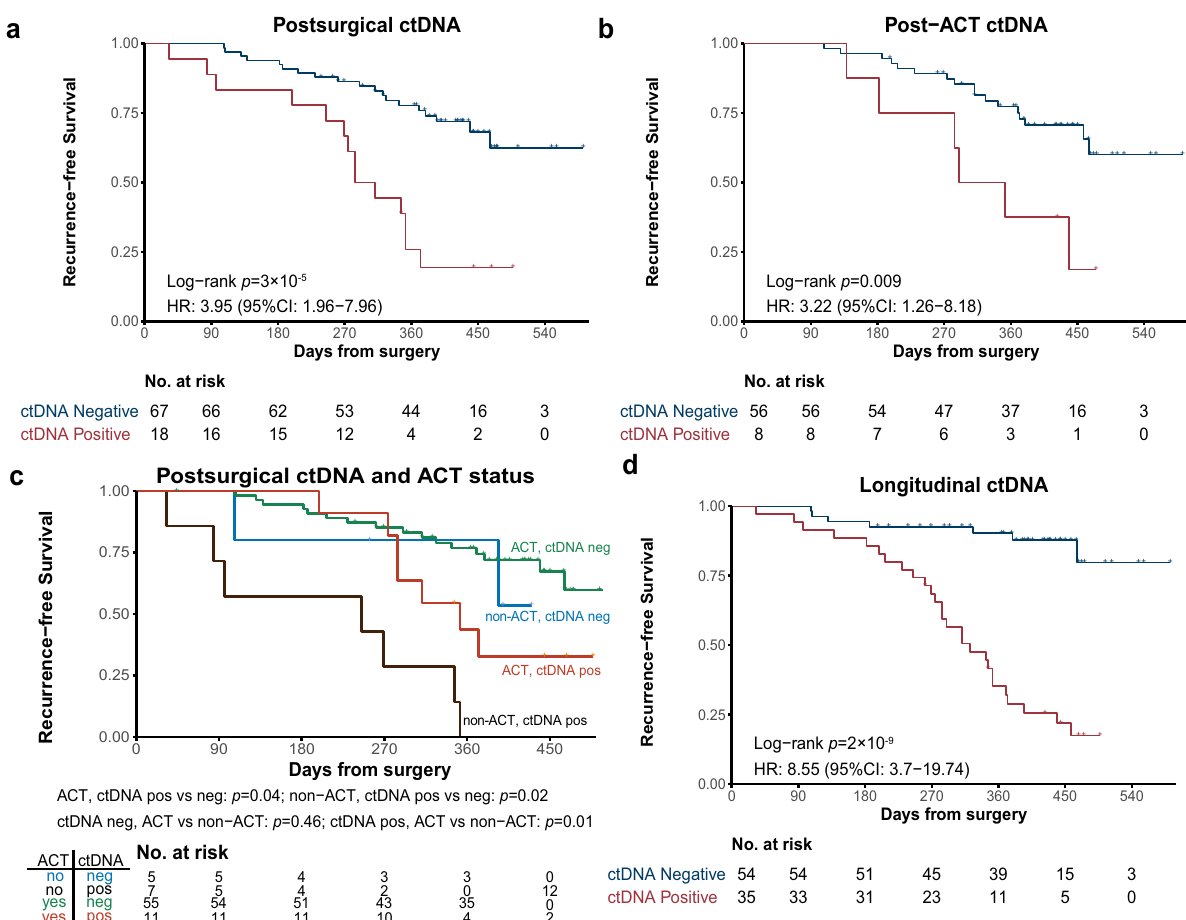
Fig. 2 ctDNA positivity could potentially serve as a prognostic marker and guide ACT treatment. a Kaplan – Meier curve of recurrence-free survival (RFS) in patients strati fi ed by postsurgical ctDNA status. p -value was calculated by the log-rank test. b Kaplan – Meier curve of RFS in patients strati fi ed by post- ACT ctDNA status. p -value was calculated by the log-rank test. c Kaplan – Meier curve of RFS in stage II – III patients strati fi ed by both ACT treatment and postsurgical ctDNA status. p -value was calculated by the log-rank test for each comparison without adjustments. d Kaplan – Meier curve of RFS in patients strati fi ed by longitudinal ctDNA status. p -value was calculated by the log-rank